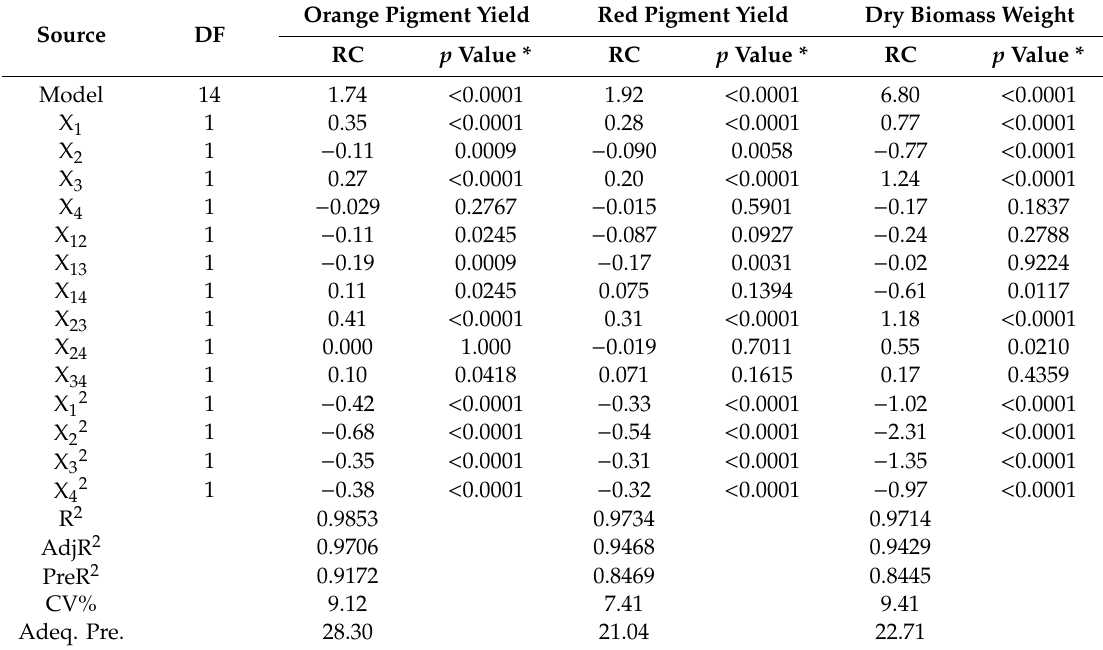
Table A1. Regression coe ffi cient (RC) of the models and their statistical parameters on the responses (Xi: coded values of independent variables (i = 1: pH; i = 2: temperature, i = 3: agitation speed; i = 4: fermentation time) and their